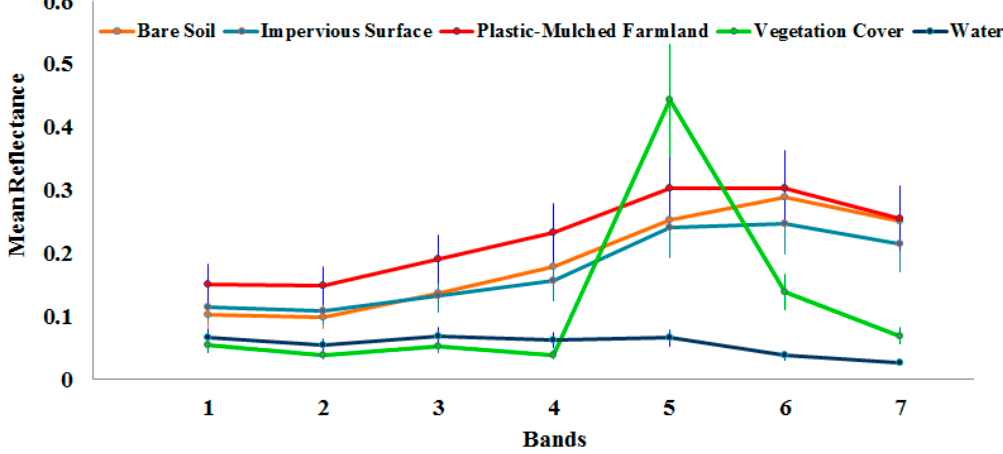
Figure 3. Spectral separability of different land cover classes on the different bands of Landsat-8 OLI imagery (1: Coastal Aerosol; 2: Blue; 3: Green; 4: Red; 5: NIR; 6: SWIR1; 7: SWIR2).